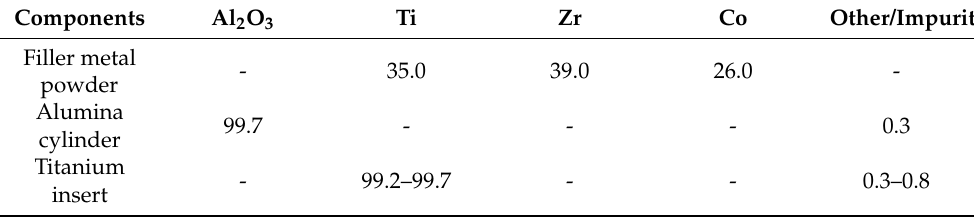
Table 1. Chemical composition of the used components.